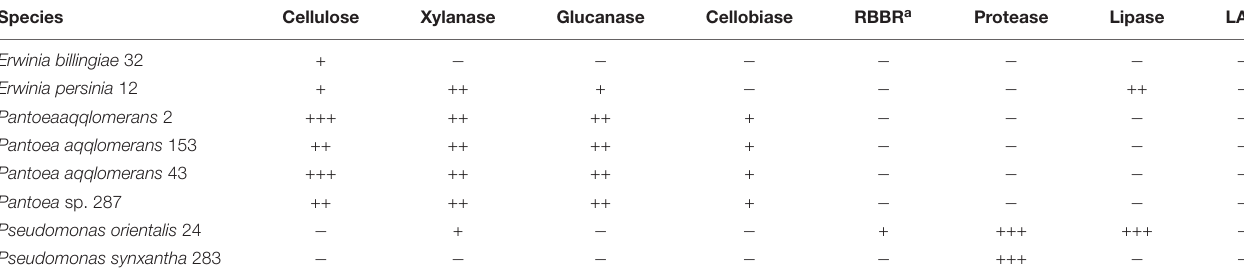
TABLE 3 | Enzymatic activities of the gut bacteria from insect larvae. Species